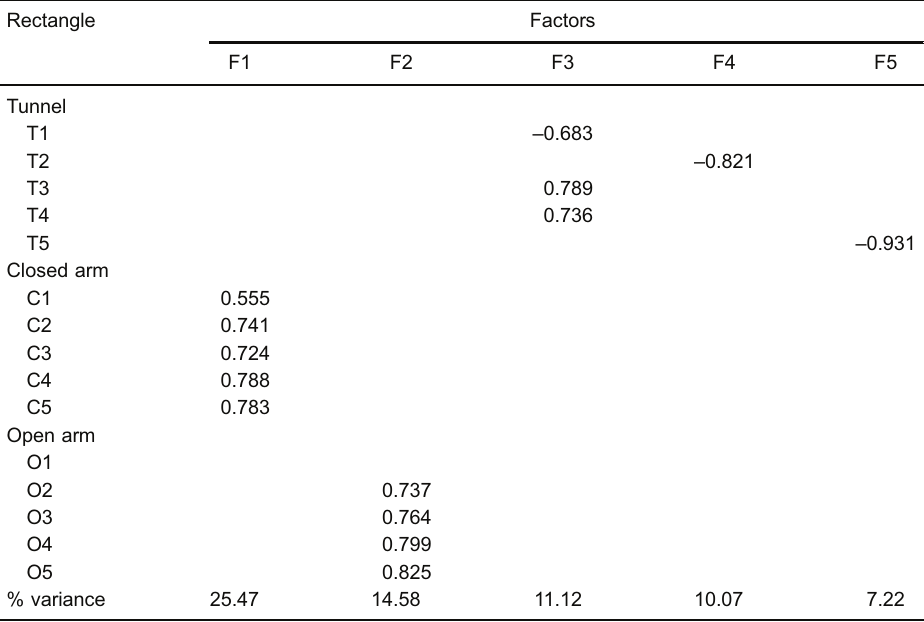
Table 2. Orthogonal factor loadings for time in the rectangles, frequency of entries, and time spent in the 15 rectangles into which the elevated gradient of aversion test fl oor was